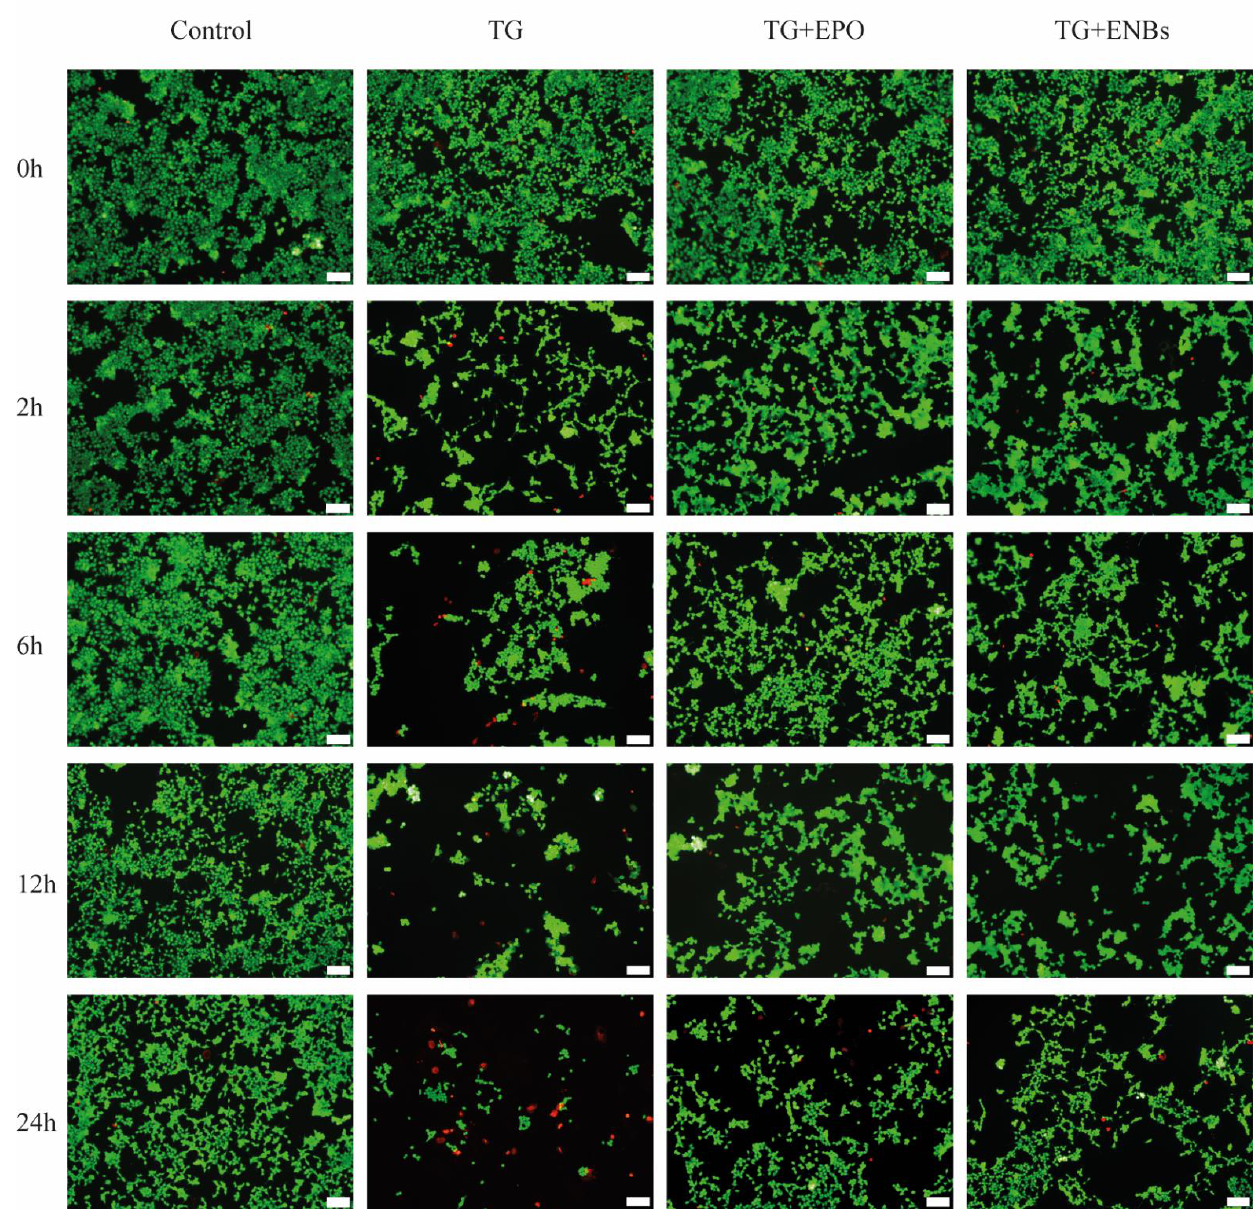
Figure 2. Live/dead fluorescence images of SH-SY5Y cells over 24 h. The control group in this experiment was the cell-only group. TG indicates thapsigargin treatment, TG + EPO indicates thapsigargin and EPO cotreatment, and TG + ENBs indicates thapsigargin and EPO nanobot cotreatment. Green represents live cells, while red represents dead cells. The scale bars are 100 μm.